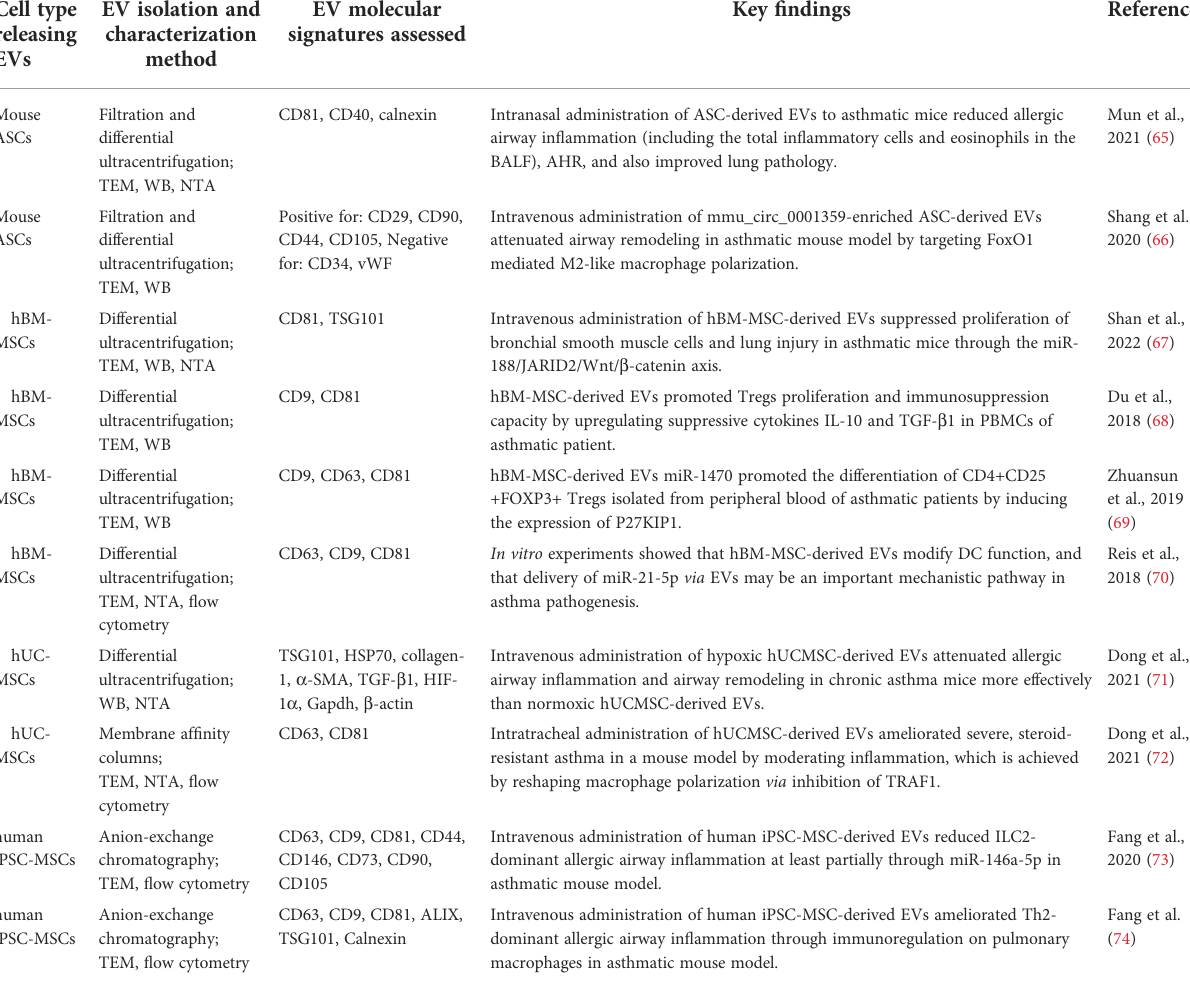
TABLE 1 Mesenchymal-Stem-Cell-Derived extracellular vesicles (MSC-EVs) and their reported role in attenuating asthma